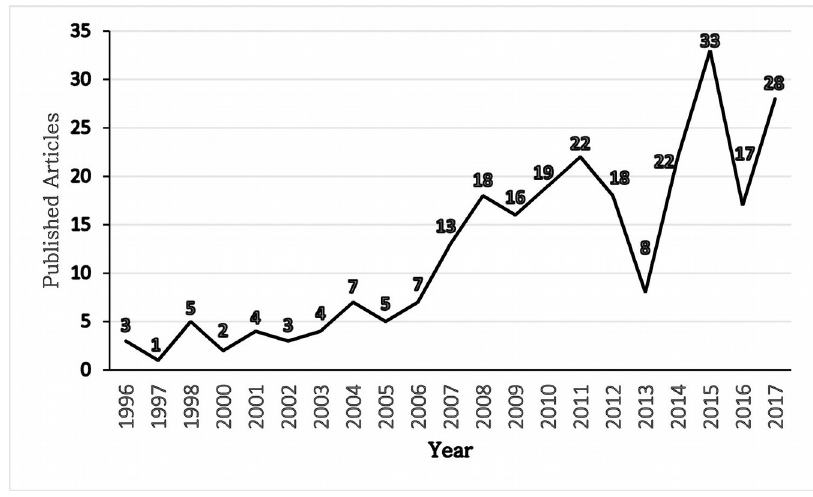
Figure 1. Number of published articles per year